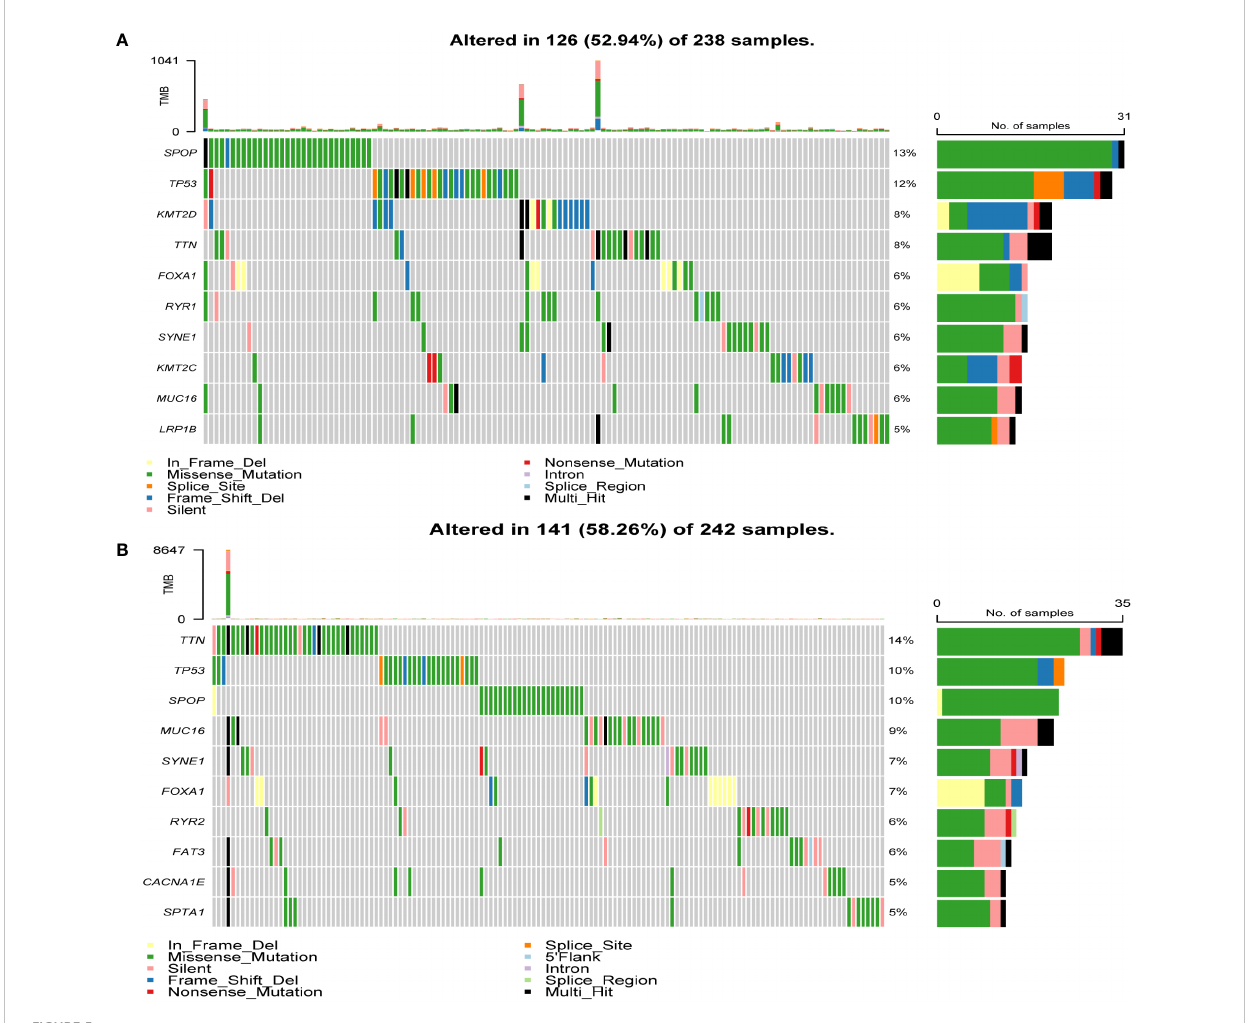
FIGURE 5 Heterogeneity of tumor mutations between the high and low-risk groups. (A) Mutational landscape diagram in the high-risk group. (B) Mutational landscape diagram in the low-risk